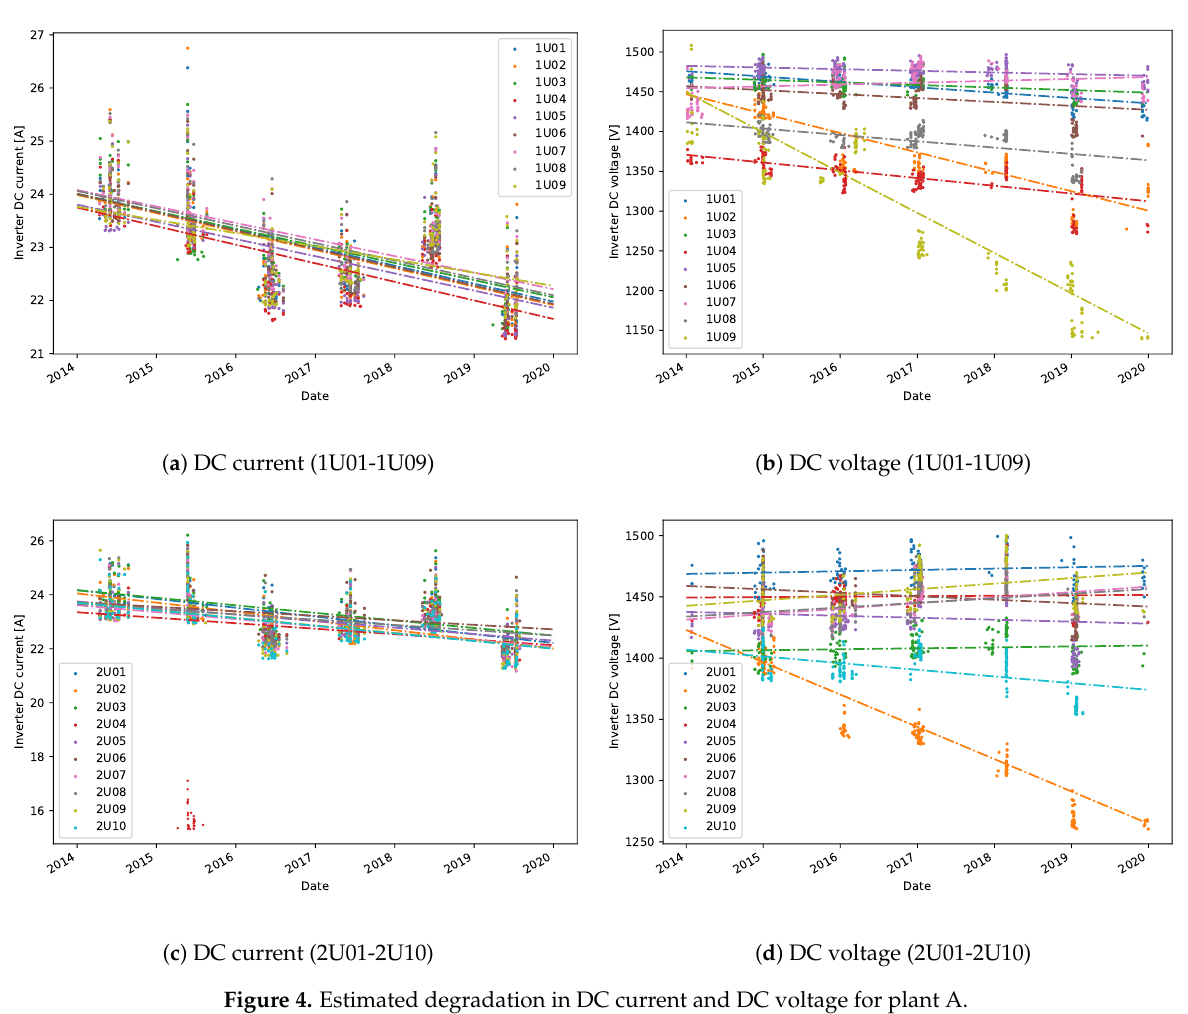
Figure 4. Estimated degradation in DC current and DC voltage for plant A. Table 3. DC current and DC voltage yearly degradation for plant A using the sampled values—based ap-